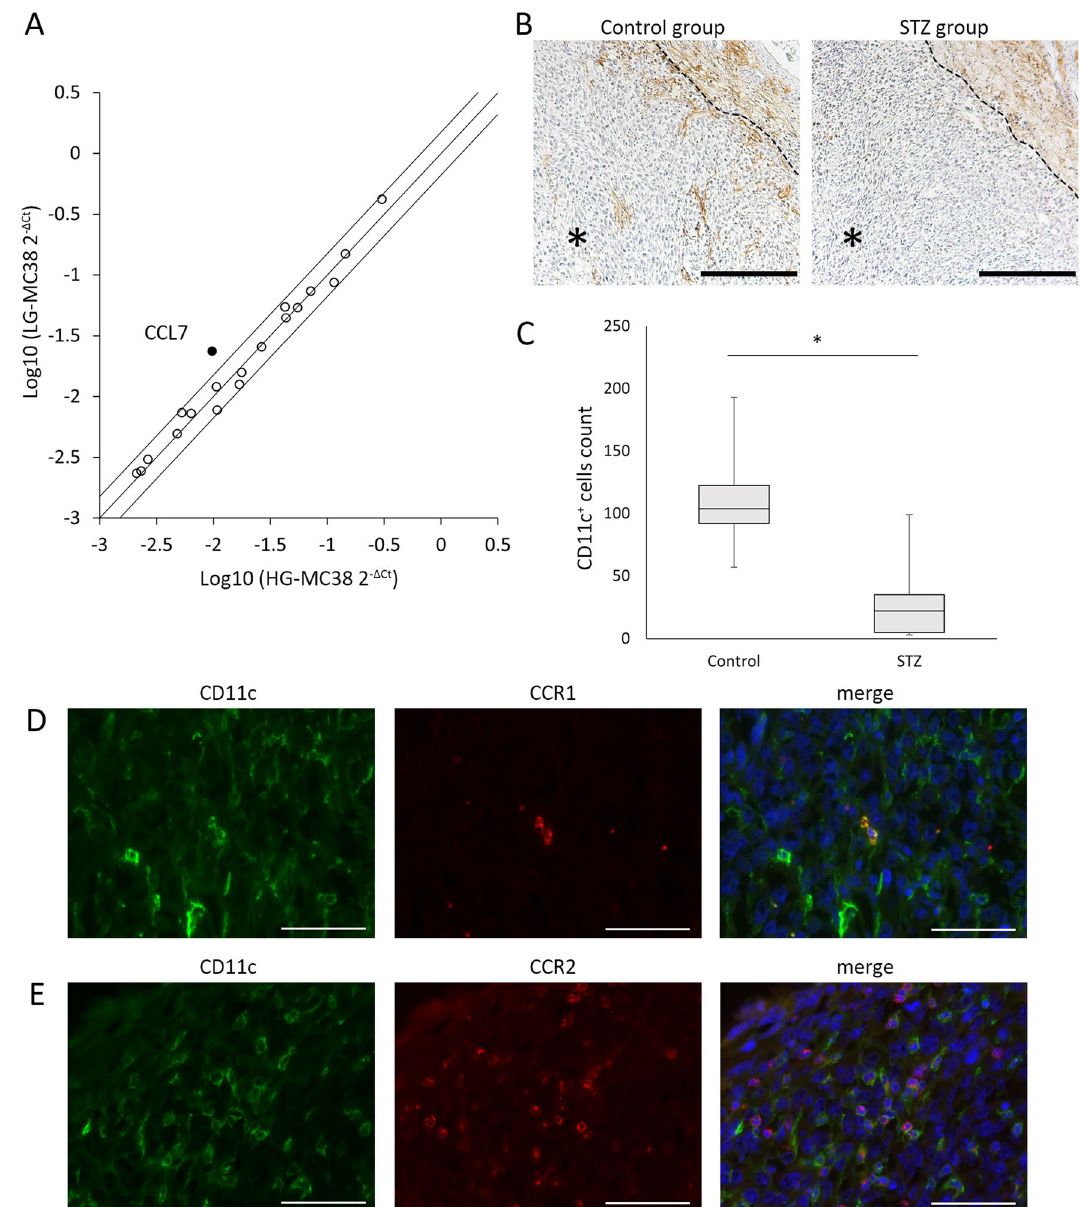
Figure 3. The effect of hyperglycemia on the expression of chemokines and chemokine receptors in MC38 cells and the number of tumor-infiltrating CD11c + cells. ( A ) Scatterplot of mRNA expression levels of chemokines and chemokine receptors in MC38 cells cultured with low glucose media (LG-MC38) or with high glucose media (HG-MC38) analyzed by the RT 2 Profiler PCR Array. The middle line indicates that the expression levels are equal between LG-MC38 and HG-MC38. The upper and lower lines indicate a 1.5-fold increase or decrease in LG-MC38 compared to HG-MC38. ( B ) Immunohistochemical staining of CD11c + cells in MC38 tumors in the control or STZ groups. Scale bars, 200 µm. The dashed line indicates the edge of the tumor. Asterisk: tumor tissue area. ( C ) The number of CD11c + cells in MC38 tumors in the control and STZ groups. Boxes indicate median values with interquartile range, and whiskers indicate the lowest and highest values. ( D,E ) Double immunofluorescence microscopy shows the expression of CCR1 (red) ( D ) or CCR2 (red) ( E ) on CD11c + cells (green) in MC38 tumor, respectively. Scale bars, 50 µm. Kruskal–Wallis and Mann–Whitney U tests with Bonferroni correction are used in ( C ). *P < 0.05. STZ